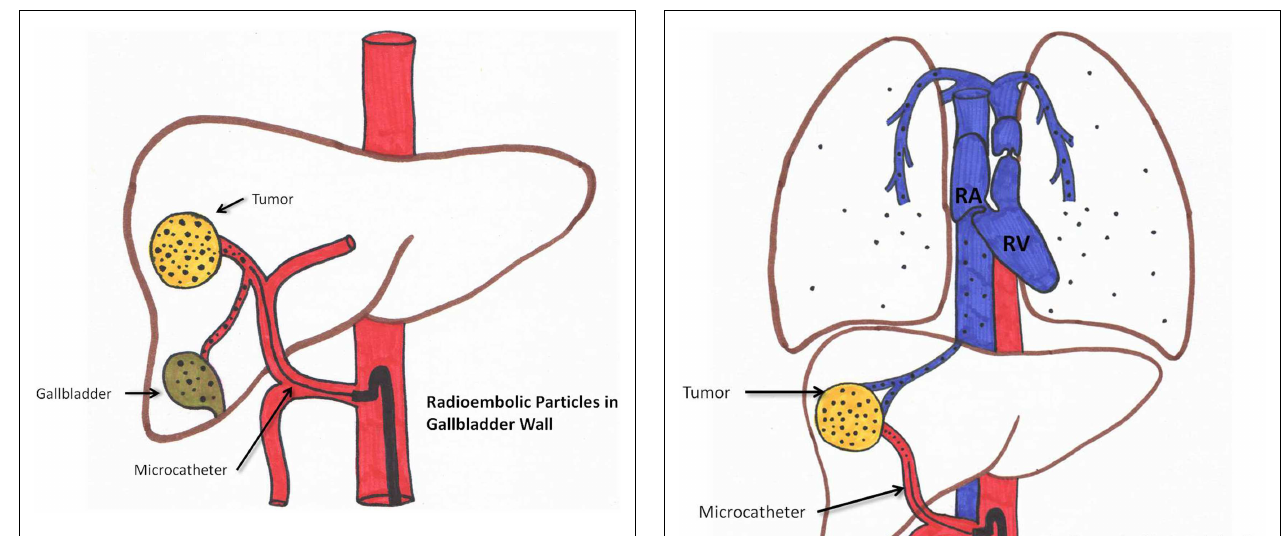
FIGURE 4 | Schematic representation of aberrant microsphere deposition in the gallbladder wall .